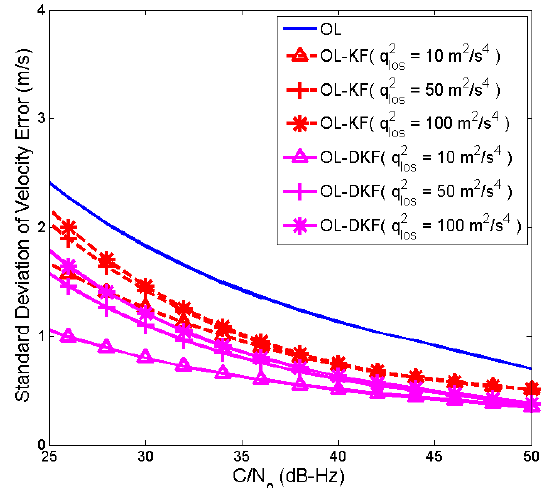
Figure 10. Standard deviation of the velocity error (6 sats).